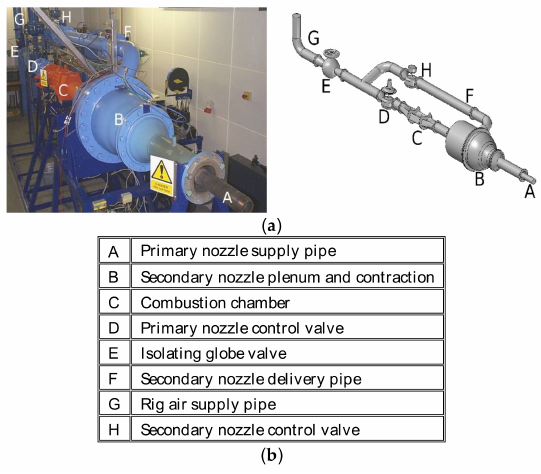
Figure 1. High Pressure Nozzle Test Facility. ( a ) Photo and schematic of facility layout; ( b ) Labelled facility